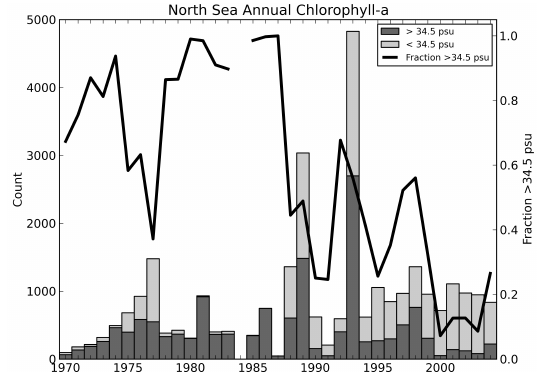
Fig.18. ThenumberofNorthSeainsituChlorophyllmeasurements,groupedintoahighsalinity(Sal. > Fig. 18. The number of North Sea in situ chlorophyll measurements, 34 . 5 PSU)indarkgreyandlowsalinity(Sal. < 34 . 5 PSU)inlightgrey. Thedarklineshowsthefraction grouped into a high salinity (Sal. > 34 . 5psu) in dark grey and low of high salinity. ] There is a gap in 1984 due the absence of simultaneous measurements of Chlorophyll salinity (Sal. < 34 . 5psu) in light grey. The dark line shows the frac- and salinity. tion of high salinity. There is a gap in 1984 due to the absence of simultaneous measurements of chlorophyll and